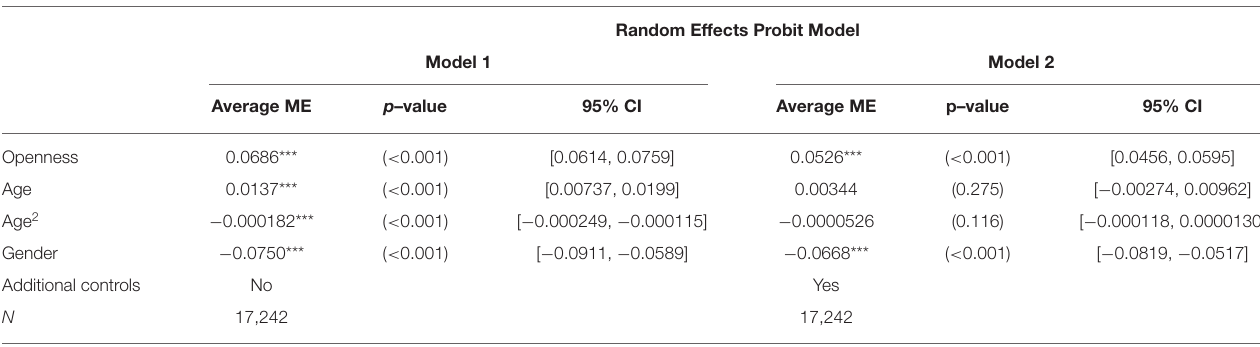
Panel B: Participation in informal further